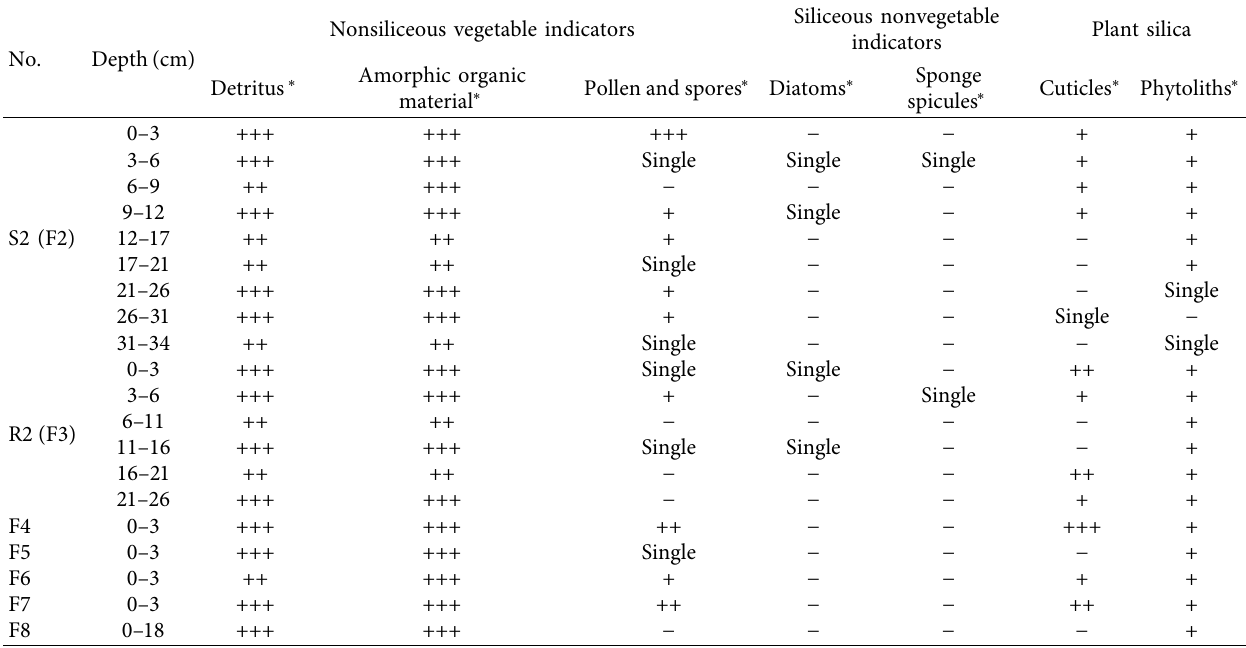
Table 7: Semiquantitative content of different types of microbiomorphs of the studied soils. No. Depth